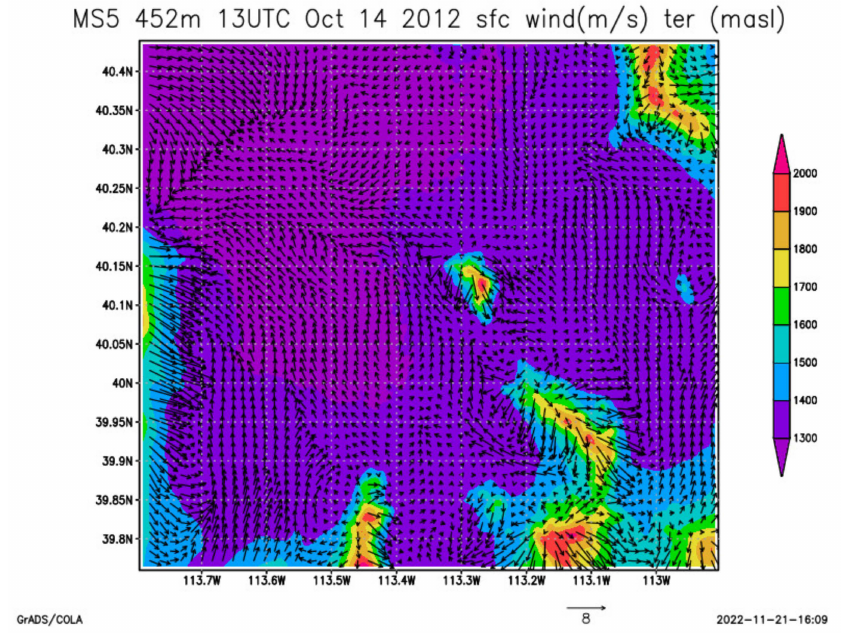
Figure 16. Model MS5 surface 10 m AGL wind vectors (m/s) for nest 4 (0.452 km), plotted over the model terrain (m ASL), valid at 1300 UTC